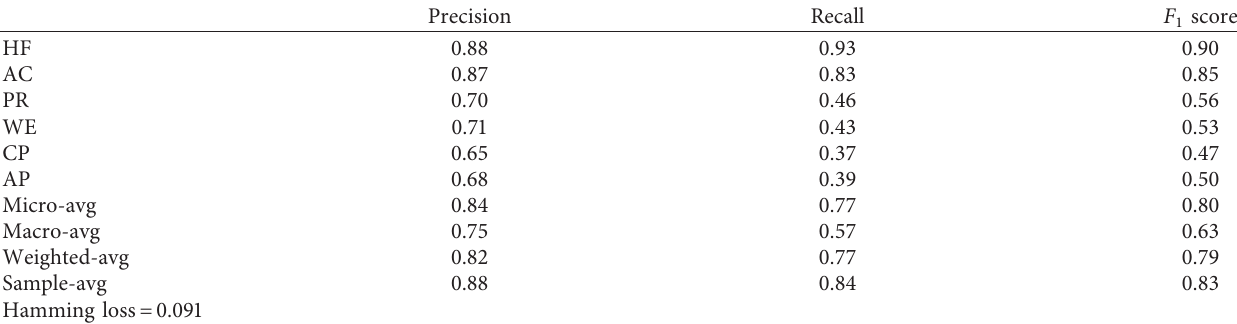
Table 11: A summary of our model’s performance in identification of multiple causal